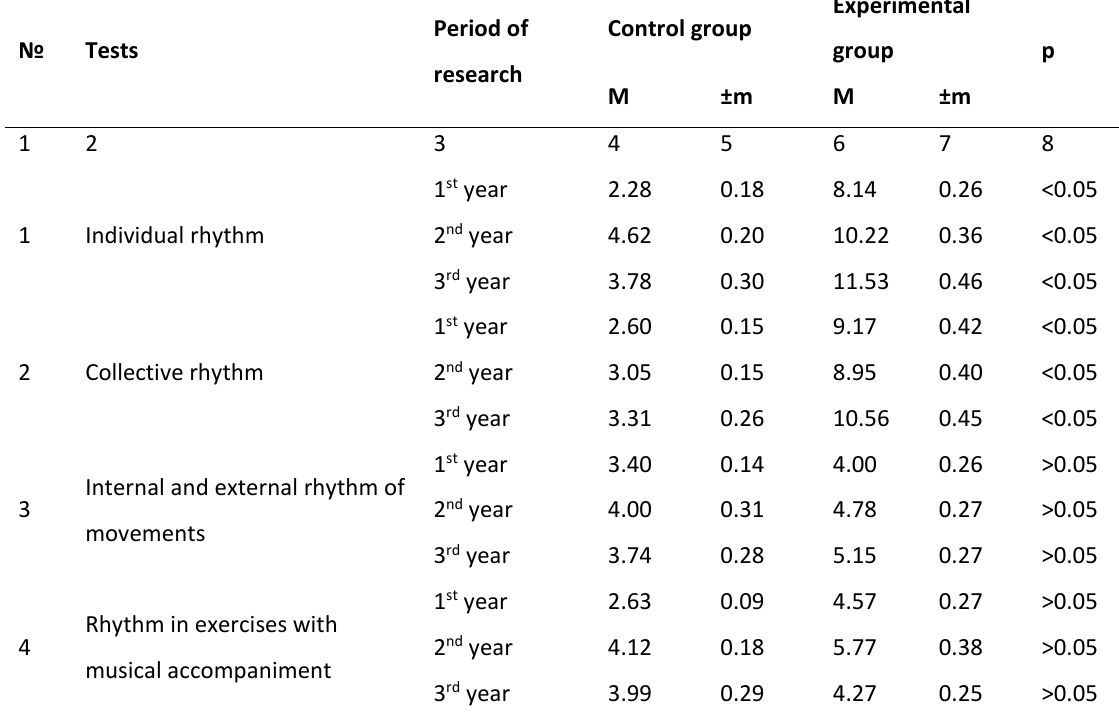
Table 1 . Increment of indicators ( %) of different kinds of rhythm